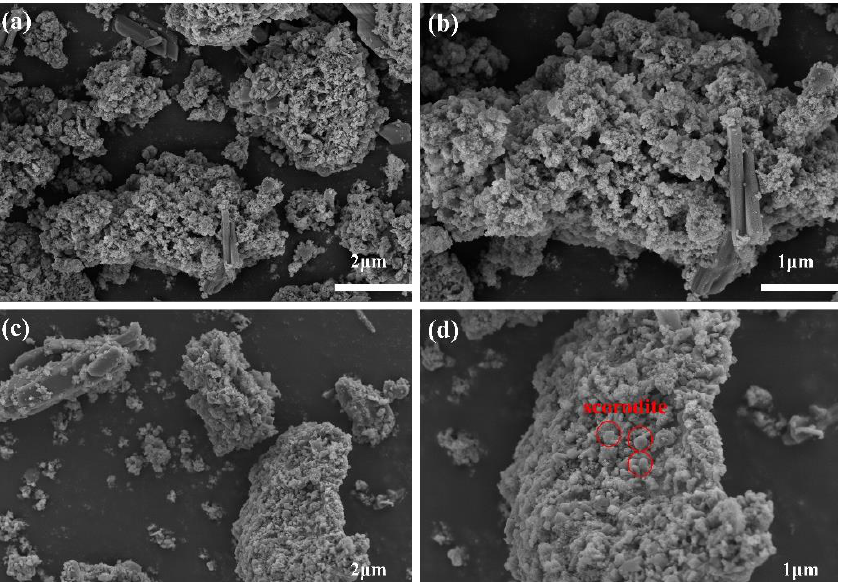
Figure 6. SEM images of As-bearing precipitate obtained at 25 °C ( a , b ), As-bearing precipitate obtained at 85 °C with a solid – liquid ratio of 1:10 and H 2 O 2 volume ratio of 10% ( c , d ).